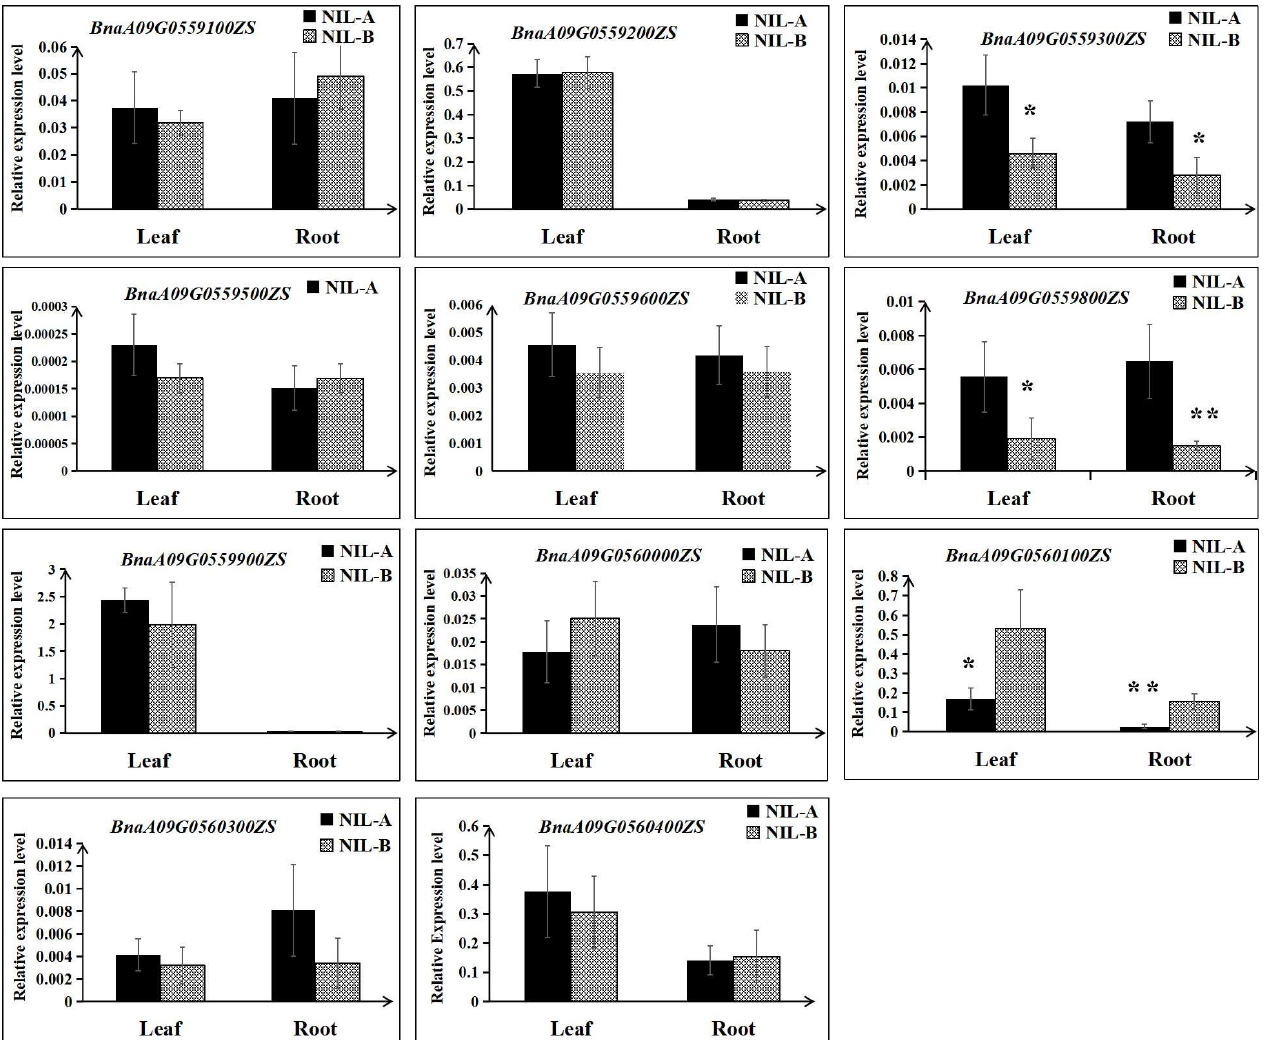
Figure 6. Relative expression levels of the eleven candidate genes between NIL-A and NIL-B. The mean and the standard deviation were calculated using three biological replicates. ** and * indicate significant differences with p < 0.01 and p < 0.05, respectively.